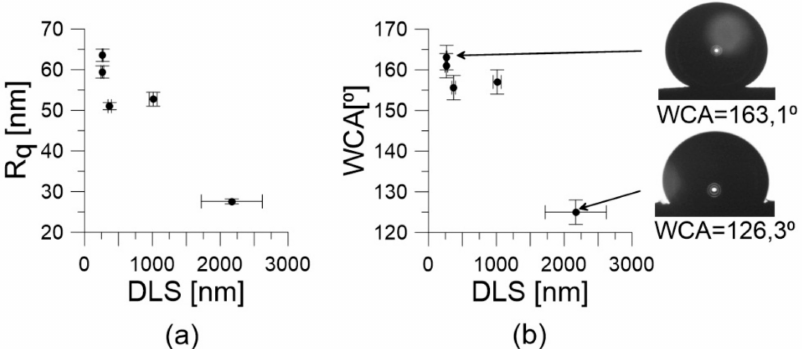
Figure 4. ( a ) The correlation between roughness factor (Rq) and DLS diameter; ( b ) The relation between water contact angle (WCA) and DLS